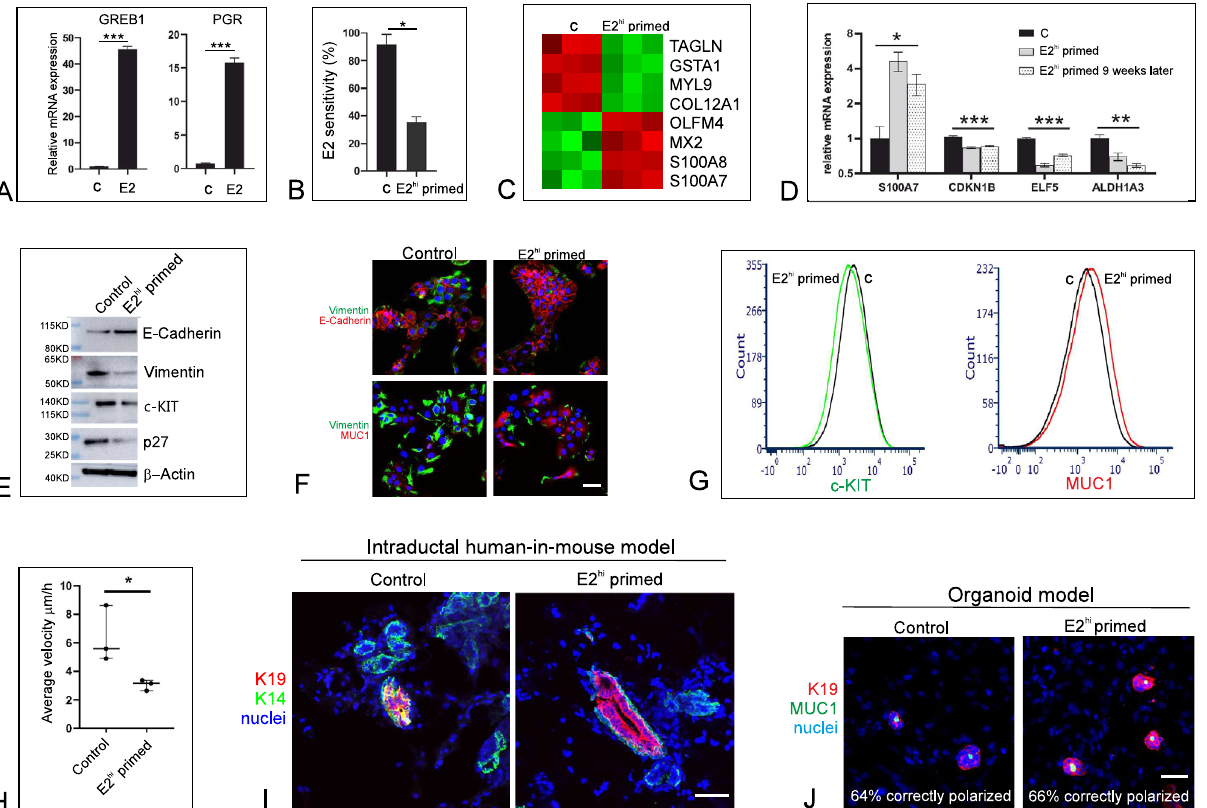
Figure 1. ( A ) iHBEC ERpos are hormonally sensitive as shown by relative RT-qPCR of GREB1 and PGR upon E2 exposure (E2) versus control (C), fold expression mean + /− SEM, ***p < 0.001 by t-test. ( B ) Reduced relative increase in cell number in E2 hi primed cells versus control upon exposure to low E2, mean + /− SEM, *p < 0.05 by t-test. ( C ) Heat map of differentially expressed parity-related genes in E2 hi primed versus control created using R (version 3.6.3) and R studio (version 1.2.5033). Red and green indicate up- and down-regulation, respectively. ( D ) S100A7 up- and p27 (CDKN1B), ELF5 and ALDH1A3 down-regulated, respectively, in E2 hi primed cells (grey bar) versus control (black bar) and in E2 hi primed cells nine weeks later (dotted bar) versus its relative control, *p < 0.05, **p < 0.01 and ***p < 0.001 by ANOVA. ( E ) Up-regulation of E-cadherin and down-regulation of vimentin, c-KIT and p27 relative to β-actin by Western blotting in E2 hi primed versus control. The blots are grouped from different gels. ( F ) Confirmation by fluorescent staining of down-regulation of vimentin (green) and concurrent up-regulation of E-cadherin and MUC1 protein (red) upon E2 hi priming. ( G ) Reduction of c-KIT and increase of MUC1 expression by FACS analysis upon E2 hi priming. ( H ) Reduction of average